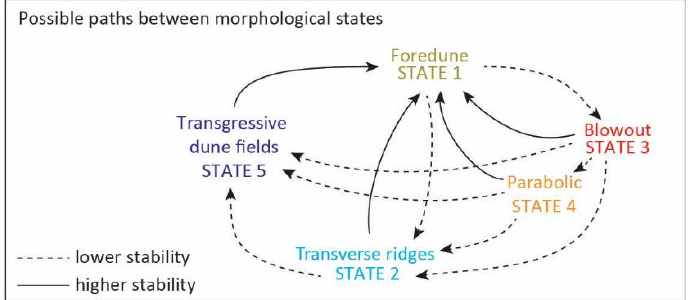
Figure 9. Diagram showing possible fluctuations or shifts between system states defined by the type of dunes (i.e., varying from fixed or foredunes to mobile transgressive dune fields). The arrows represent the possible paths between states, implying an increase or decrease in system stability. State 1 represents a prograding barrier with foredune(s), State 2 is a prograding barrier with transverse ridges, State 3 corresponds to a stable-to-retreating barrier with active blowouts, State 4 is a stable-to-retreating barrier with active parabolic dunes, and State 5 represents a transgressive barrier with a transgressive dune field.